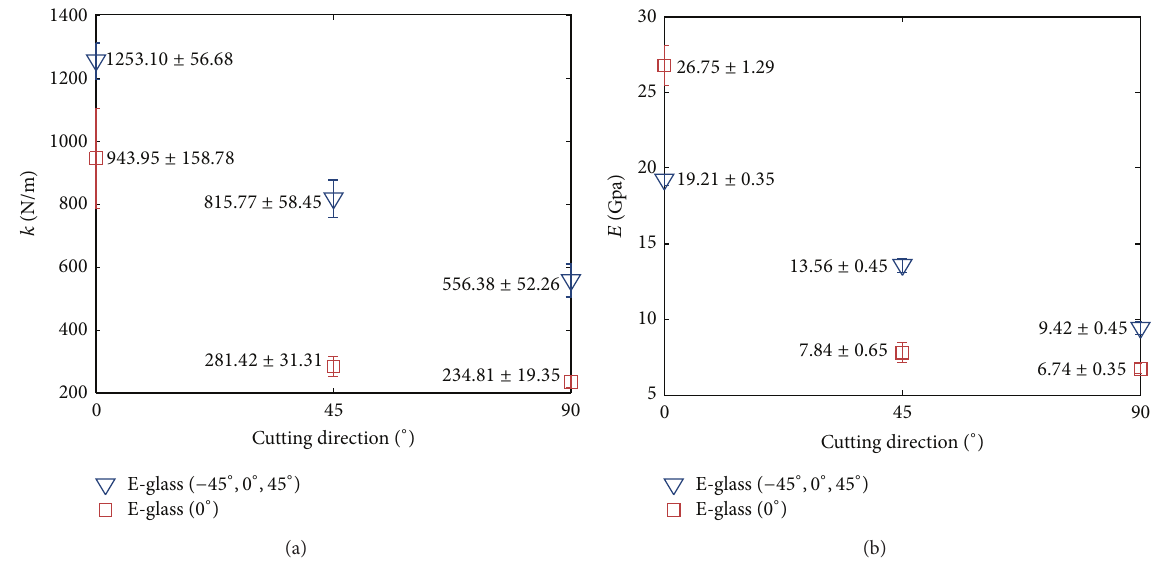
Figure 9: The resultant stiffness (a) and equivalent elastic moduli (b) of the fiberglass composite strips made by the E-glass (− 45 ∘ , 0 ∘ , 45 ∘ ) and the E-glass ( 0 ∘ ) with three different cutting